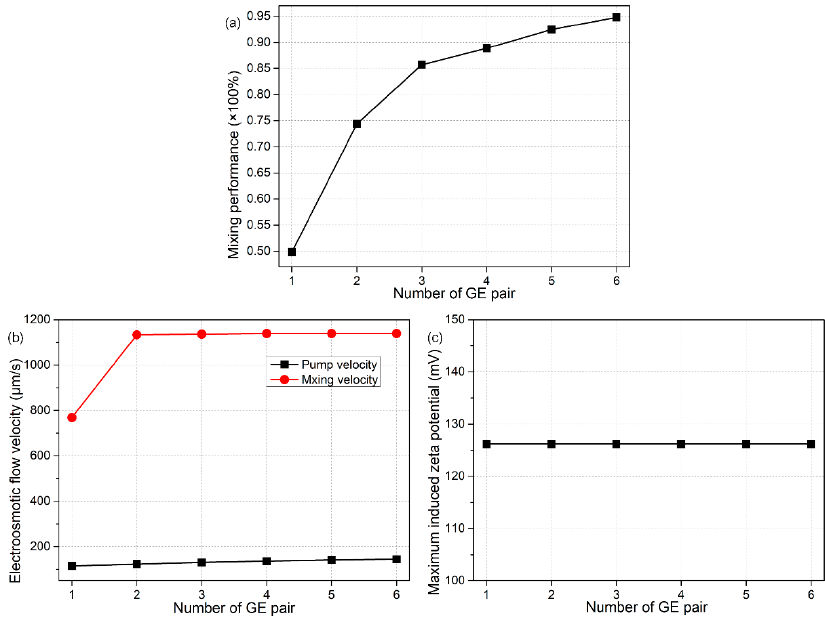
Figure 7. Effect of the number of gate electrode terminals ( n ) on the dual functionalities of the integrated device configuration, for given values of Vs = 70 V, V G1 = − V G2 = 900 V, L G = 150 μm and L GG = 100 μm. ( a ) n -dependent mixing performance. ( b ) Pump and mixing electroosmotic flow velocity as a function of the number of gate electrode pairs. ( c ) The largest value of induced zeta potential at the polarized liquid/membrane interface for a distinct number of G terminal pairs.